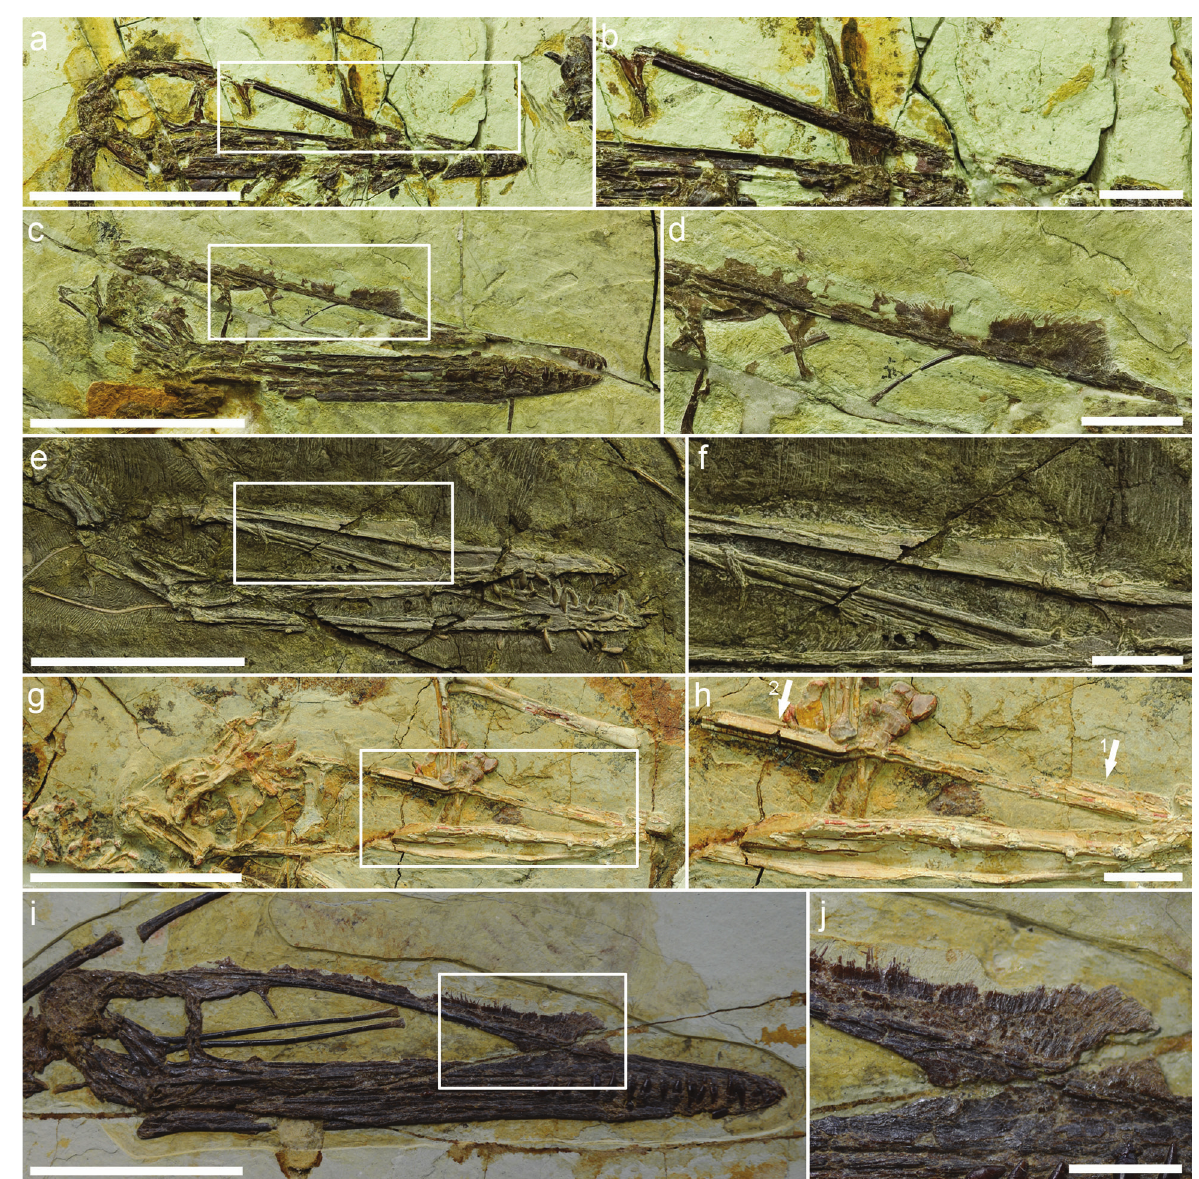
Figure 1 - The variation of cranial crest within the Wukongopteridae. Kunpengopterus sinensis (IVPP V 16047), (a) complete skull and (b) close-up of the area in the white frame of a, showing the flat crestless skull roof; holotype of Darwinopterus linglongtaensis (IVPP V 16049), (c) complete skull and (d) close-up of the area in the white frame of c; new specimen (IVPP V 17957), (e) complete skull (inverted), and (f) close-up of the area in the white frame of e; IVPP V 17959 (g) complete skull (inverted), and (h) close-up of the area in the white frame of g, with arrow 1 pointing at the low premaxillary crest and arrow 2 pointing at the crestless middle portion of the premaxilla; Darwinopterus robustodens (holotype, HGM 41HIII-0309A) (i) complete skull based on Lü et al. 2011b), and (j) close-up of the area in the white frame of i. Scale bar: 50mm in a, c, e, g, i; 10mm in b, d, f, h, j (see the colors in the online